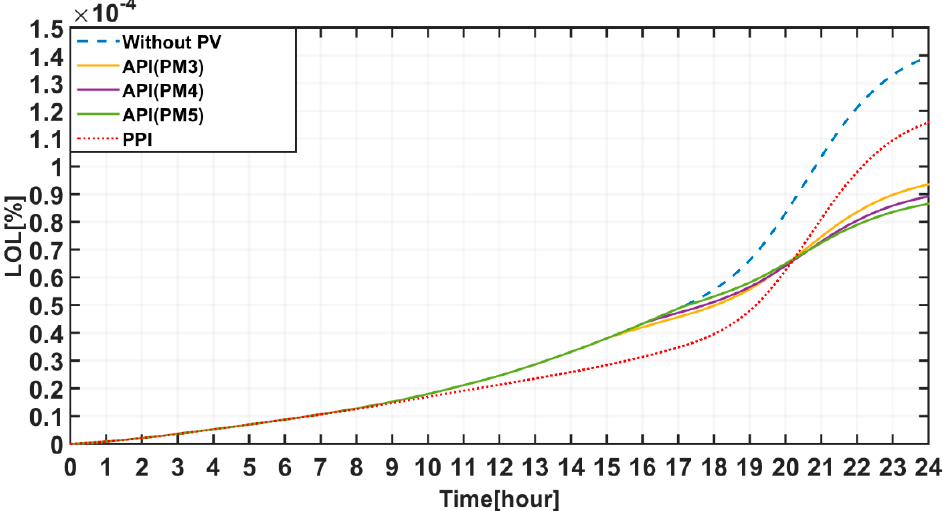
Figure 11. LOL profile with different PV integration approaches (EV penetration ratio: 20%).